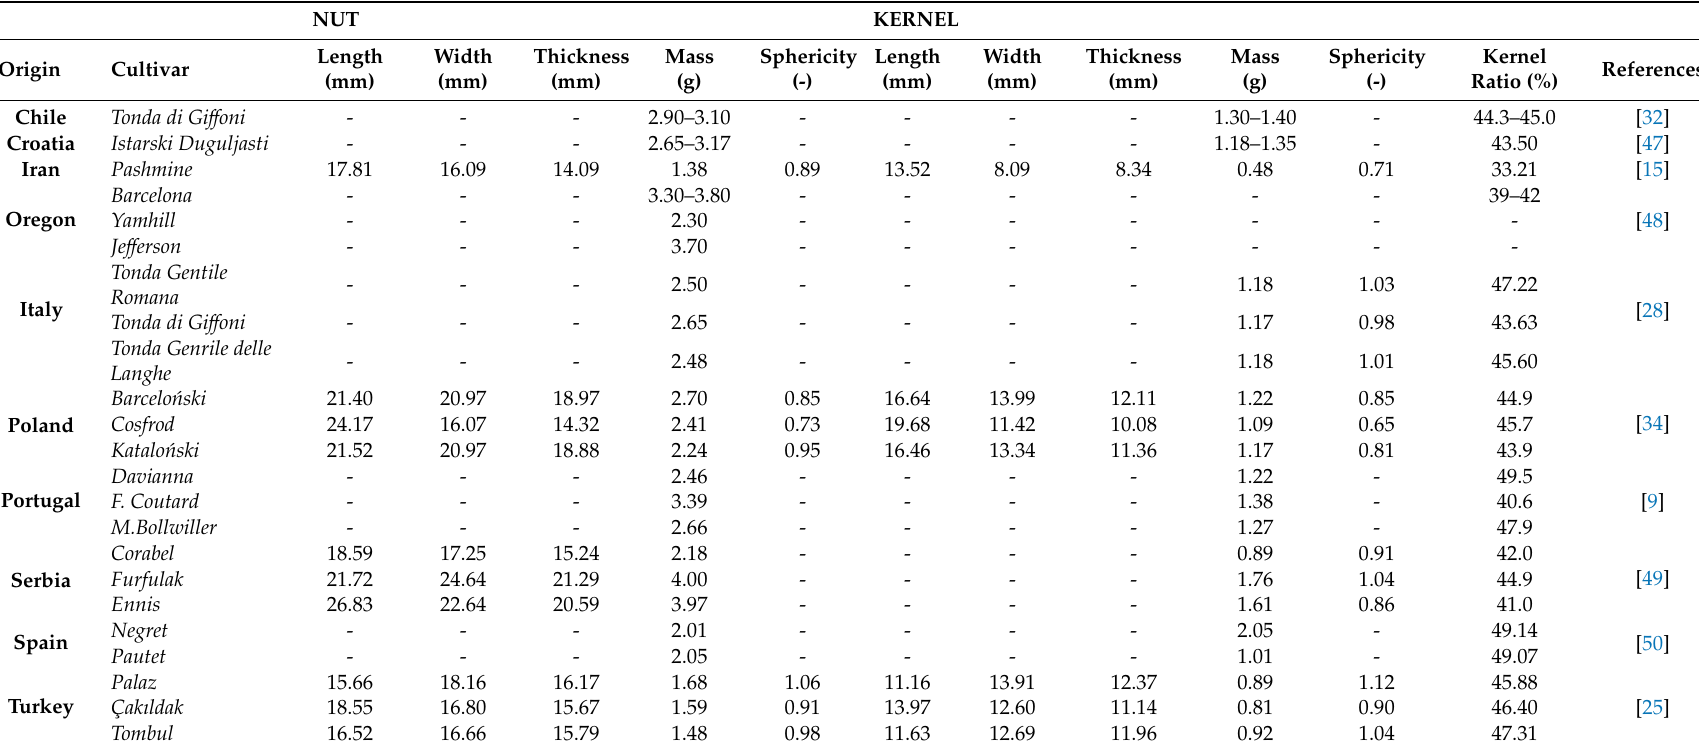
Table 1. Morphological characteristics of the nut and kernels of hazelnut cultivars from di ff erent origins. NUT